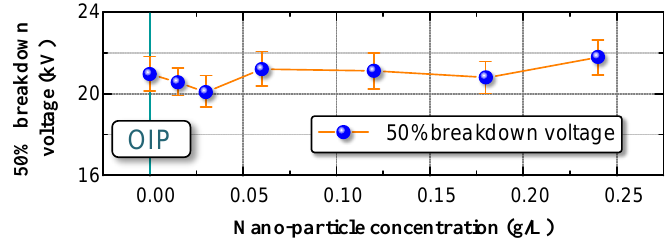
Figure 6. U 50 of oil-impregnated paper (OIP) and nano-OIP (NOIP) with different nano-TiO 2 particle concentrations.